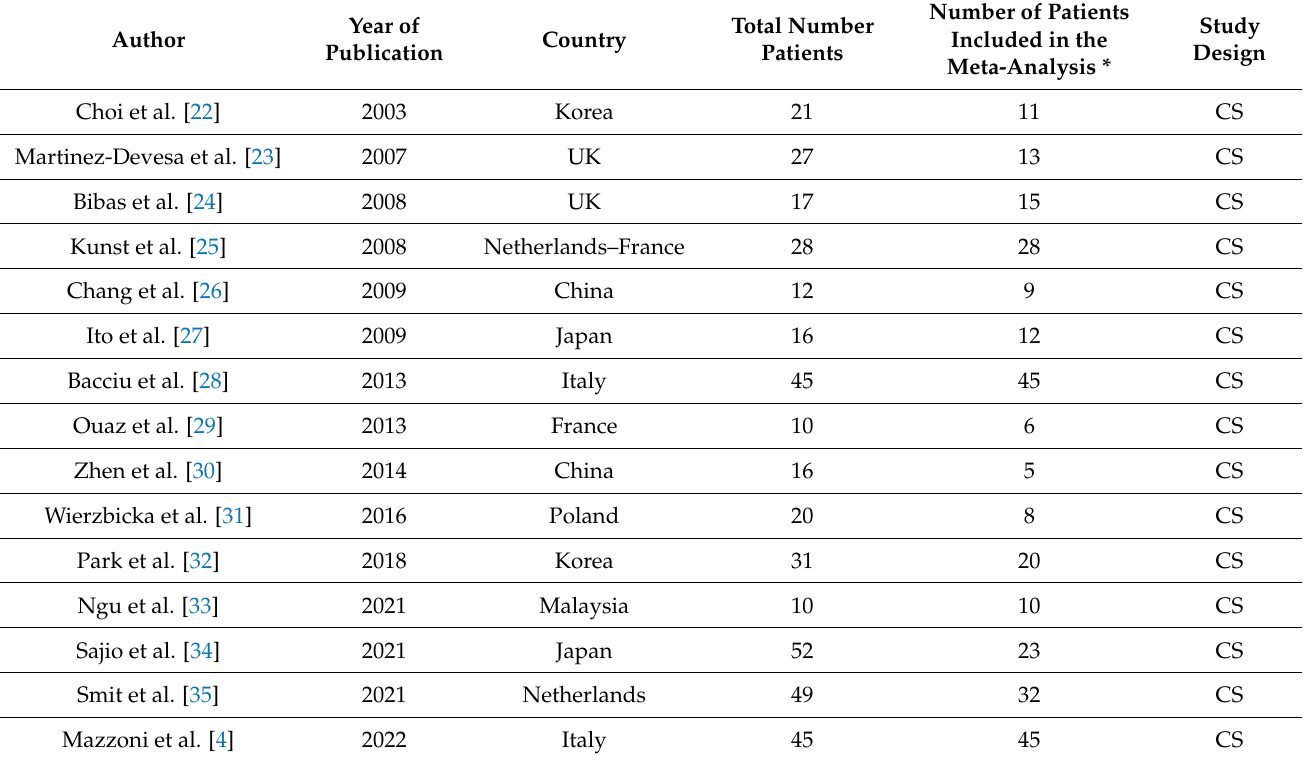
Table 1. Characteristics of the articles included in the meta-analysis.